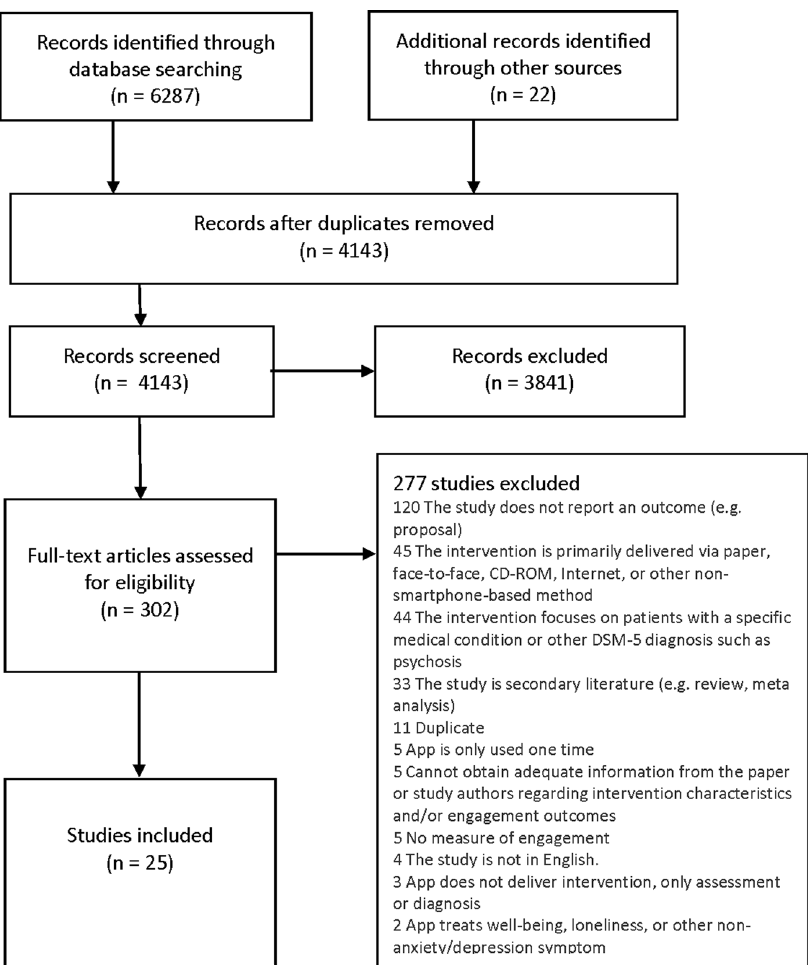
Fig. 1 PRISMA fl owchart. Flow diagram of article selection